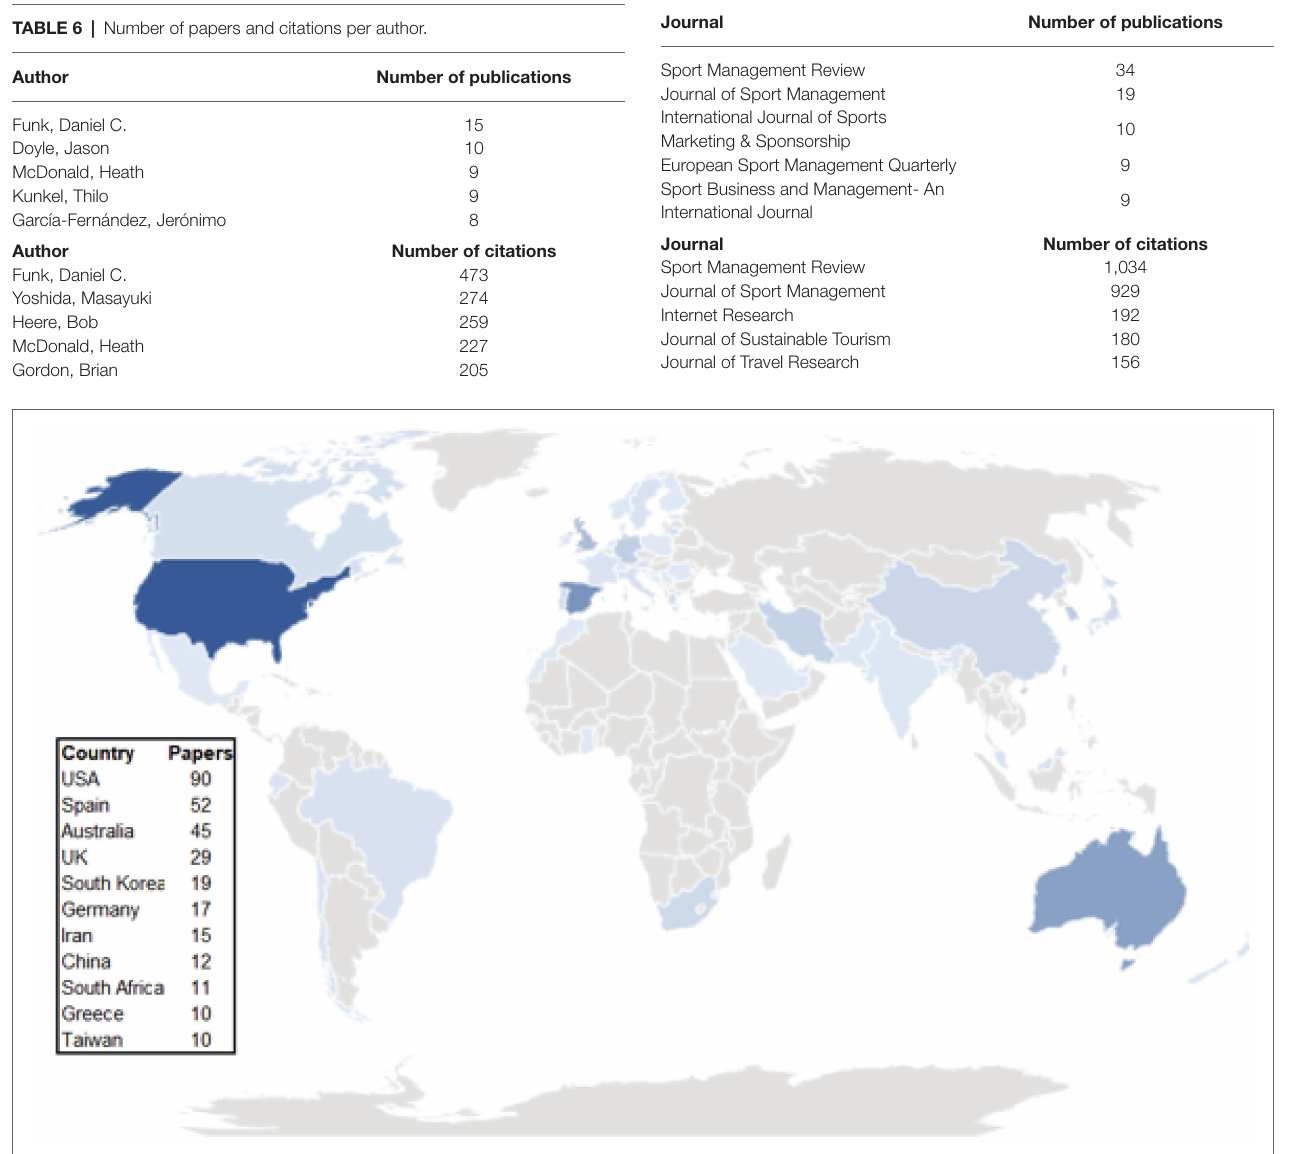
FIGURE 3 | Geographic distribution of loyalty and sport management.